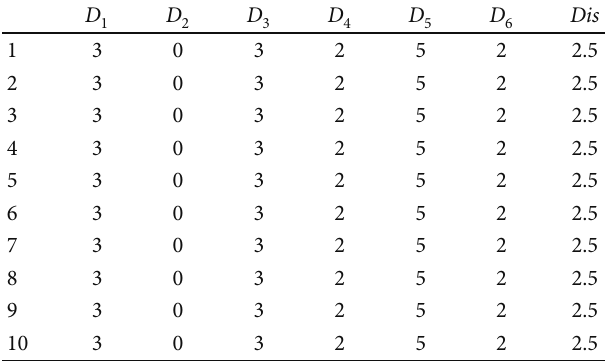
Table 4: Disturbance strength calculation process.